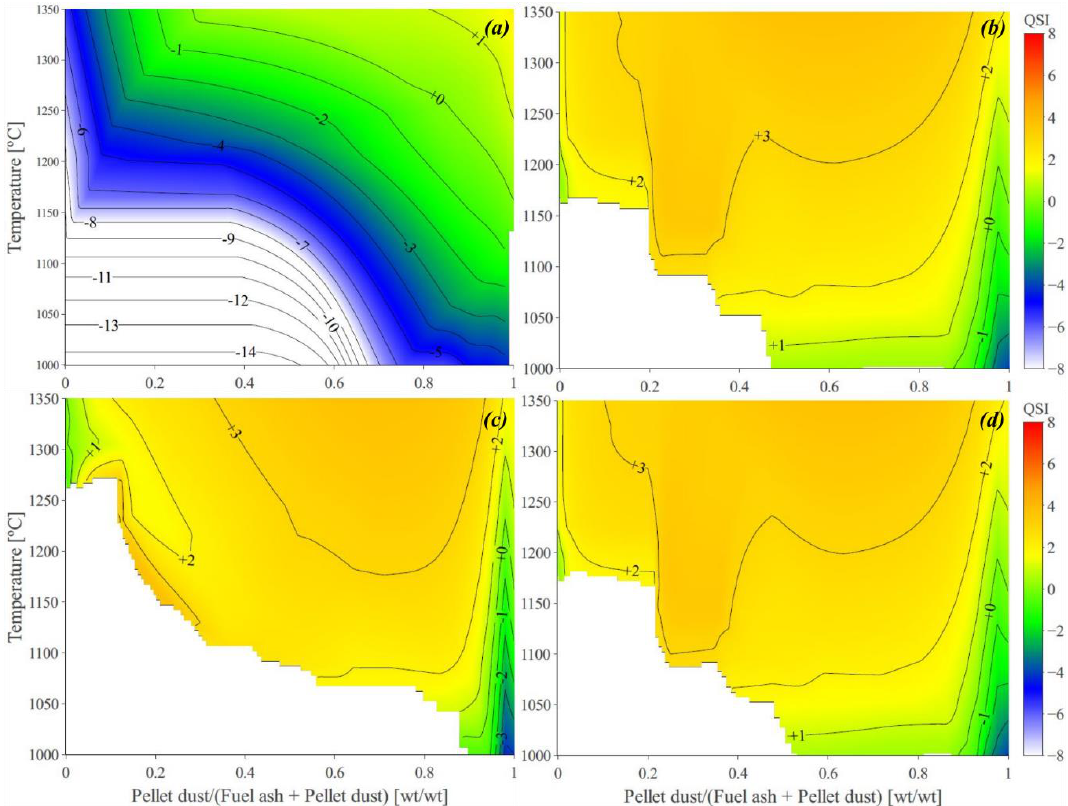
Figure 5. Calculated QSI (qualitative slagging indicator) for ( a ) coal; ( b ) raw stem wood; ( c ) stem wood-pyrolysis oil; ( d ) stem wood-biochar, from 1000 to 1350 °C. Viscosity is expressed in ln(Pa.s).